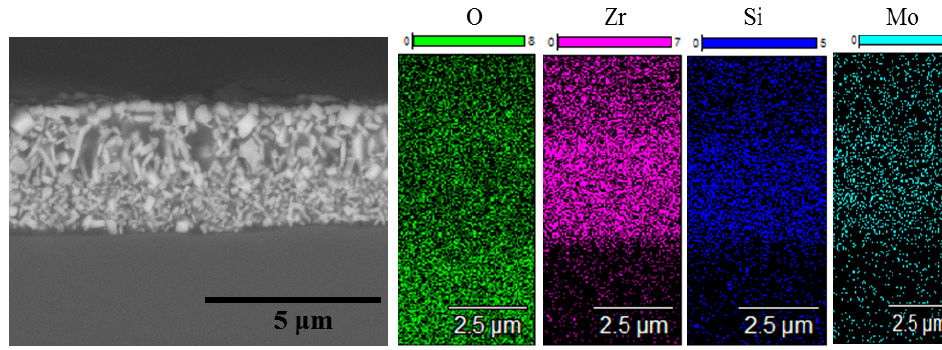
Figure 9. Cross-section SEM images of the Zr-Mo-Si-B-N coating (Coating 2N) after air annealing at 1000 ◦ C for 1 h. The figure illustrates complete oxidation.